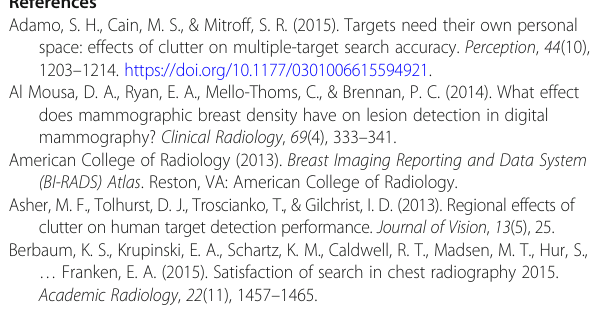
Additional file 1: Figure S1. Detection accuracy: percentage correct for individual radiologists on target present trials for (a) low-density and (b) high-density mammograms on the detection task. The three radiologists that had piloted the experiment previously are illustrated in red. Figure S2. Detection accuracy: percentage correct for individual radiologists on target absent trials for (a) low-density and (b) high-density mammograms on the detection task. The three radiologists that had piloted the experiment previously are illustrated in red. Figure S3. Detection accuracy: sensitivity (d ′ ) for individual radiologists for (a) low-density and (b) high-density mammograms. The three radiologists that had piloted the experiment previously are illustrated in red. Figure S4. Detection and localisation results: percentage correct on the localisation task for individual radiologists on trials when detection was correct for (a) low-density and (b) high-density mammograms. The three radiologists that had piloted the experiment previously are illustrated in red. Chance is 4.4% and adjusted to 9.1% when including the ROA (dotted line) with 95% confidence intervals. Figure S5. Detection and localisation results: percentage correct on the localisation task when a region of acceptance (ROA) around the lesion is included for individual radiologists for (a) low-density and (b) high-density mammograms. The three radiologists that had piloted the experiment previously are illustrated in red. Chance is 4.4% and adjusted to 9.1% when including the ROA (dotted line) with 95% confidence intervals. (DOCX 1002